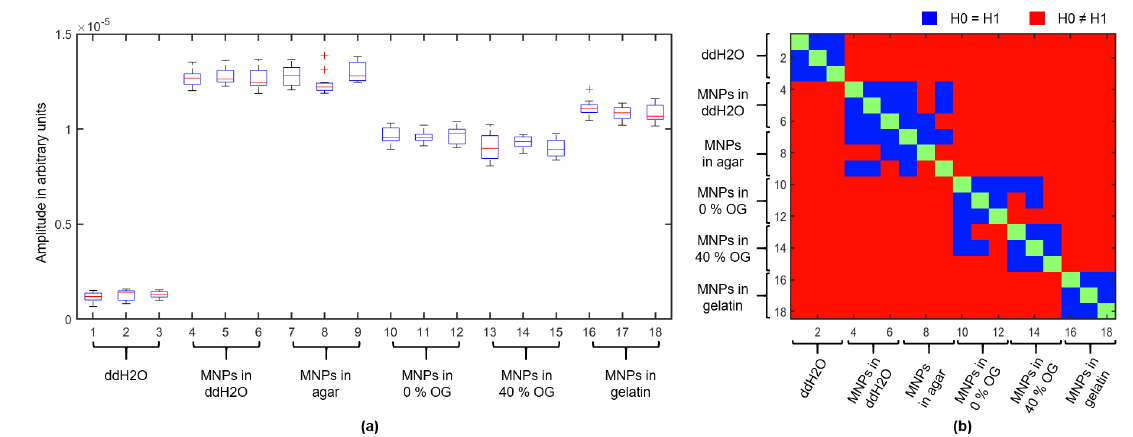
Figure 7. Results of the MNP response depending on the embedded medium, where 0% OG and 40% OG indicate the mixture ratio of oil in gelatin corresponding to Lazebnik et al. [32]. ( a ) Boxplots for each target showing the median (central mark of each box) and ± 2.7 standard deviations (whiskers). ( b ) Results of the two-sample Kolmogorov–Smirnov